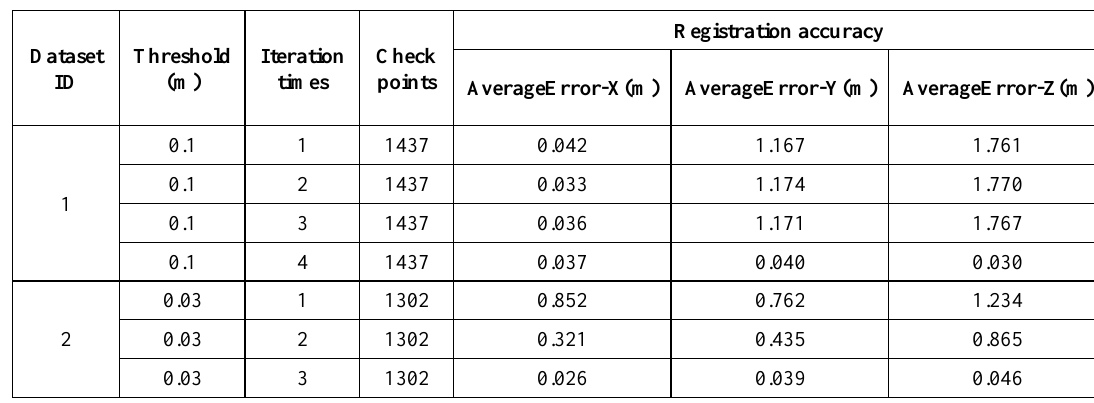
Figure 5. (a) Sample images of the first dataset in a meeting room. (b) Sample images of the second dataset along a